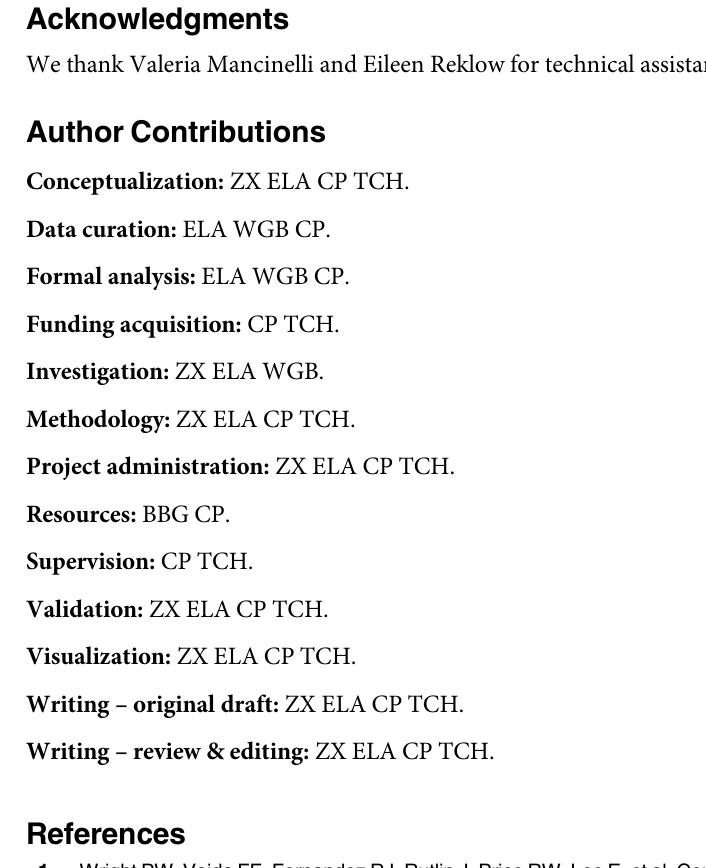
cells for 48 hours and then levels of peroxisomal proteins were determined by immunoblotting with corresponding antibodies. B. The average relative levels of peroxisomal proteins (com- pared to actin) from 3 independent experiments are shown. Error bars represent standard error of the mean. (TIF) S3 Fig. HIV-1 infection causes loss of peroxisomal proteins in Hela CD4+ cells. Hela CD4+ cells (clone 1022) were infected with HIV-1 (pYU2, MOI = 10.0) for 72 hours and then sub- jected to immunoblot analyses with antibodies to PMP70, PEX2, PEX7, PEX11B, PEX13, HIV-1 p24 and actin. The relative levels of peroxisomal proteins (compared to actin) from 3 independent experiments were averaged and plotted. Error bars represent standard error of the mean.